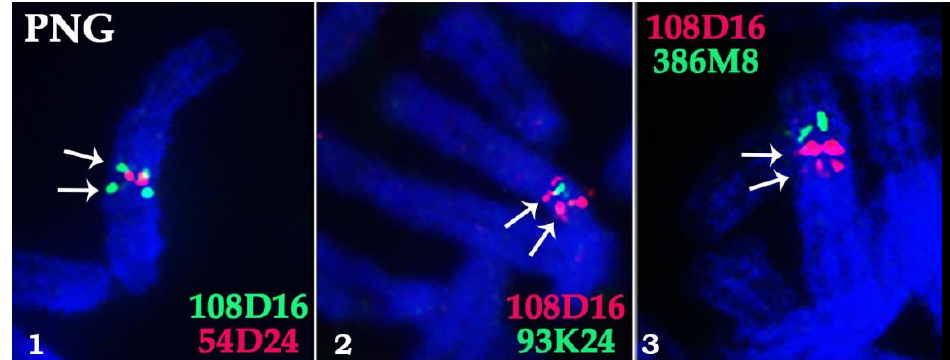
Figure 3. The duplication of the X chromosome segment in Pseudoryx nghetinhensis (PNG) shown by dual color FISH of cattle BAC-clones (pink and green) from CHORI-240 library. Three FISH experiments illustrate the revealed order of BACs on the X chromosome: 386M8, 108D16, 54D24, 93K24, 108D16. White arrows indicate the duplicated region corresponding to 108D16: 1, 2 – 54D24 and 93K24 are between duplicated regions, 3 – 386M8 is outside of duplicated region. Table 3. The order of 26 CHORI-240 BACs on Bovidae X chromosomes. The color of the cells corresponds to a given conserved syntenic segment. To display the complete scheme of evolution in Bovidae, the X chromosome maps published previously are also presented [15]. The region duplicated in saola and inverted in Caprini is labeled with a lighter colour.